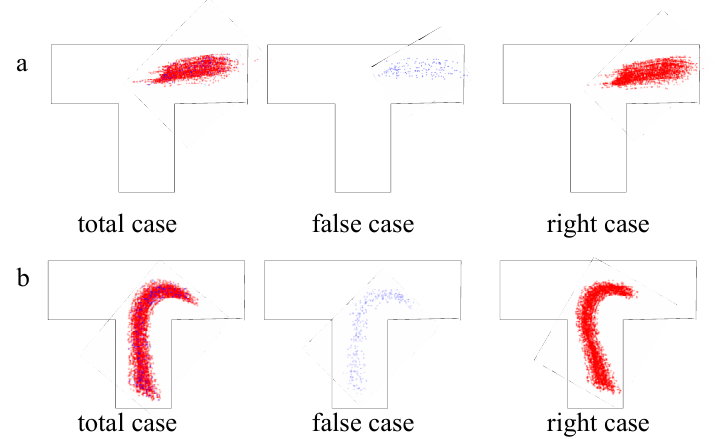
Figure 17. The distribution of the judgements on the two critical points: ( a ) The first critical point; and ( b ) The second critical